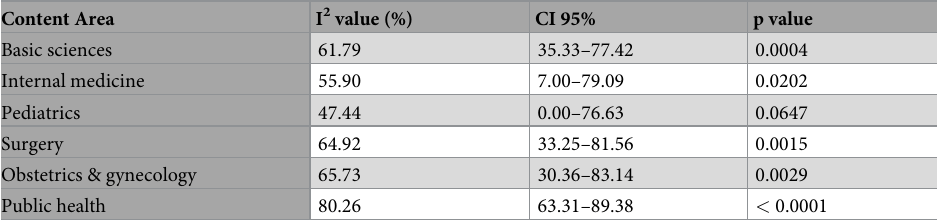
Table 2. I 2 statistics for heterogeneity evaluation in the six content areas of the